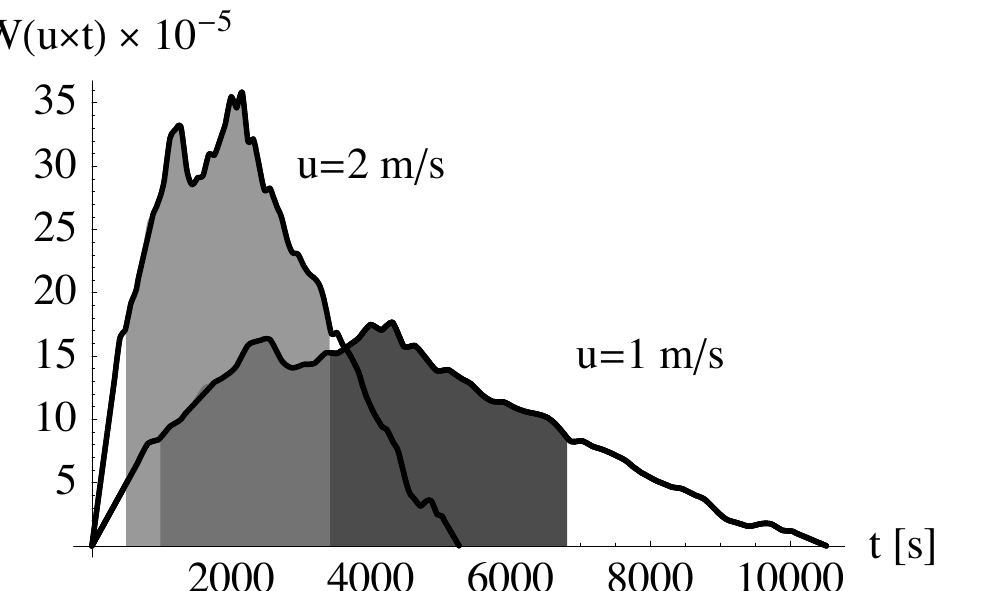
Fig. 3. Two examples unit hydrographs derived from the width function with u = 2ms − 1 (with higher peak on the left) and u = 1ms − 1 (with smaller peaks on the right). The area contributing to the maximum discharge, as derived from the Henderson’s equation and Eq. (17), is 80% of the total contributing area for each of the hydrograph and marked in grey (darker for the case u = 1 and of an intermediate tone for both the cases). In the u = 1ms − 1 case, the rainfall duration which gives (Q 1 ) MAX = 14m 3 s − 1 is (t 1 ) ∗ p = 5828s; is also (t 1 ) ∗ = 6808s (the right limit of the grey). In the case u = 2ms − 1 it is: (Q 2 ) MAX = 21 . 2m 3 s − 1 , (t 2 ) ∗ p = 2914s, (t 2 ) ∗ =